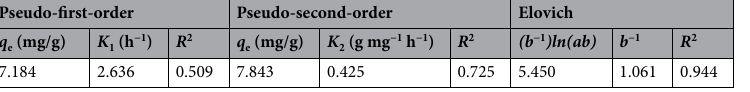
Table 7. Fitting parameters of the pseudo-first-order, pseudo-second-order and Elovich models.